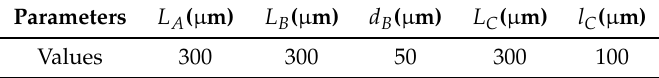
Table 2. The parameters of the coupling mechanism used for the simulation.